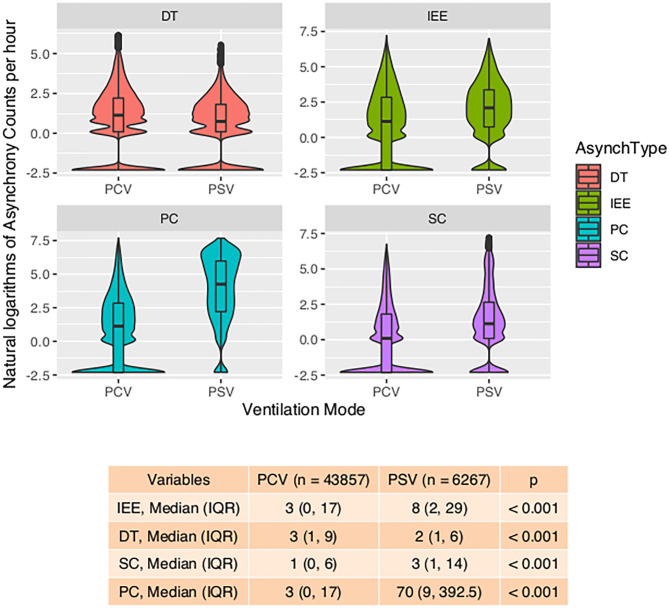
Violin plot showing the impact of ventilation mode on four types of asynchrony. Violin-and-box plots are used to visualize the distribution of the asynchrony counts (transformed by natural logarithms) and their probability density. The table at the bottom shows the number of asynchrony counts per hour. IEE, ineffective effort; DT, double triggering; SC, short cycling; PC, prolonged cycling; PCV, pressure control ventilation; PSV, pressure support ventilation.